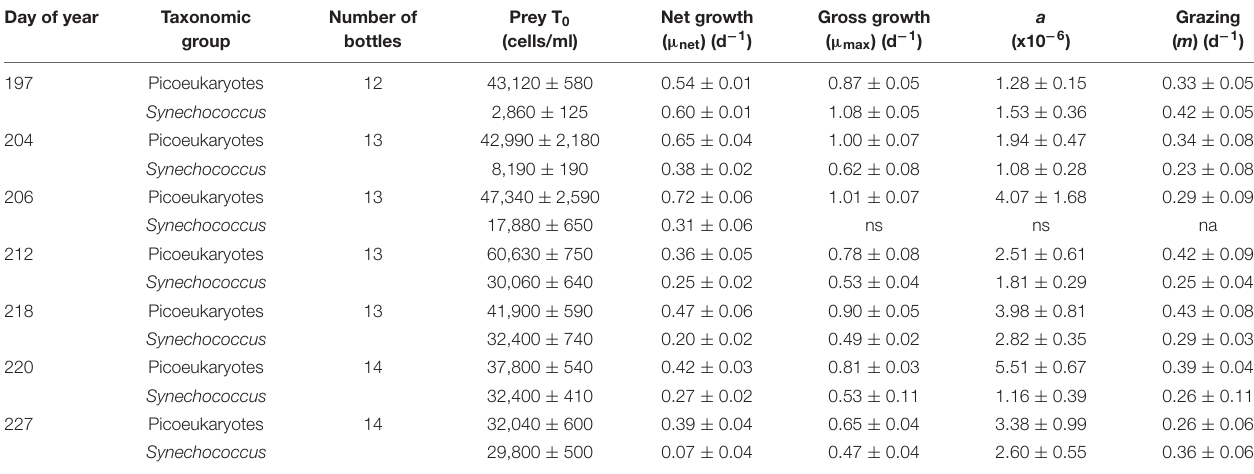
TABLE 2 | Saturation experiments in natural waters.